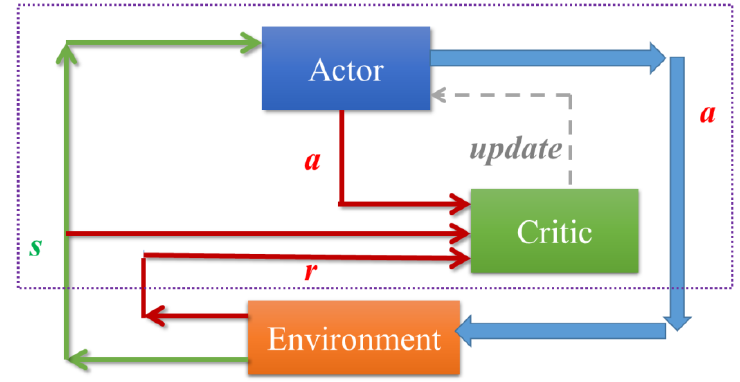
Figure 5. Actor-Critic algorithm flow chart.